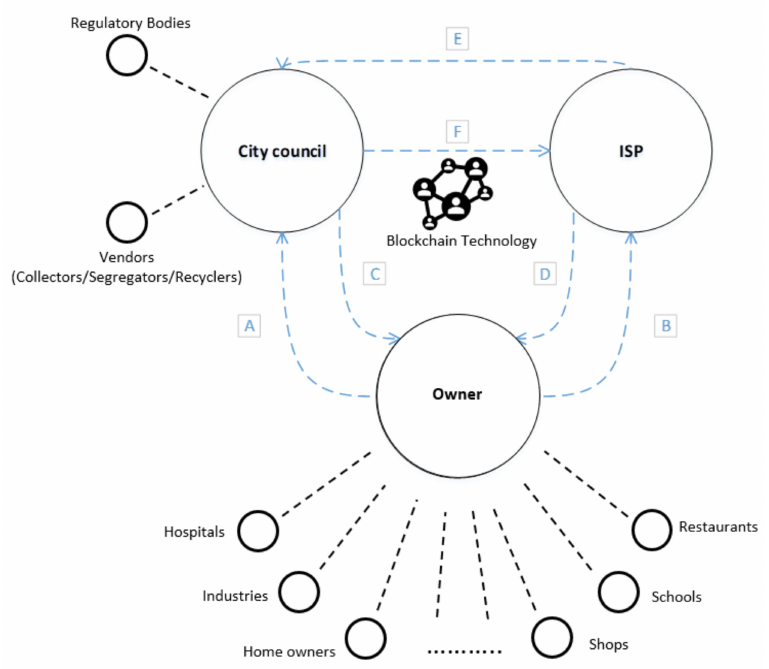
Figure 1. Relationship between entities in proposed business